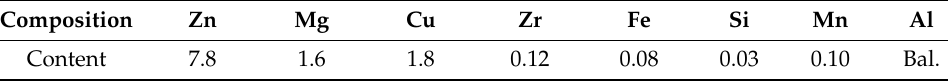
Table 1. Chemical composition of 7085 aluminum alloy